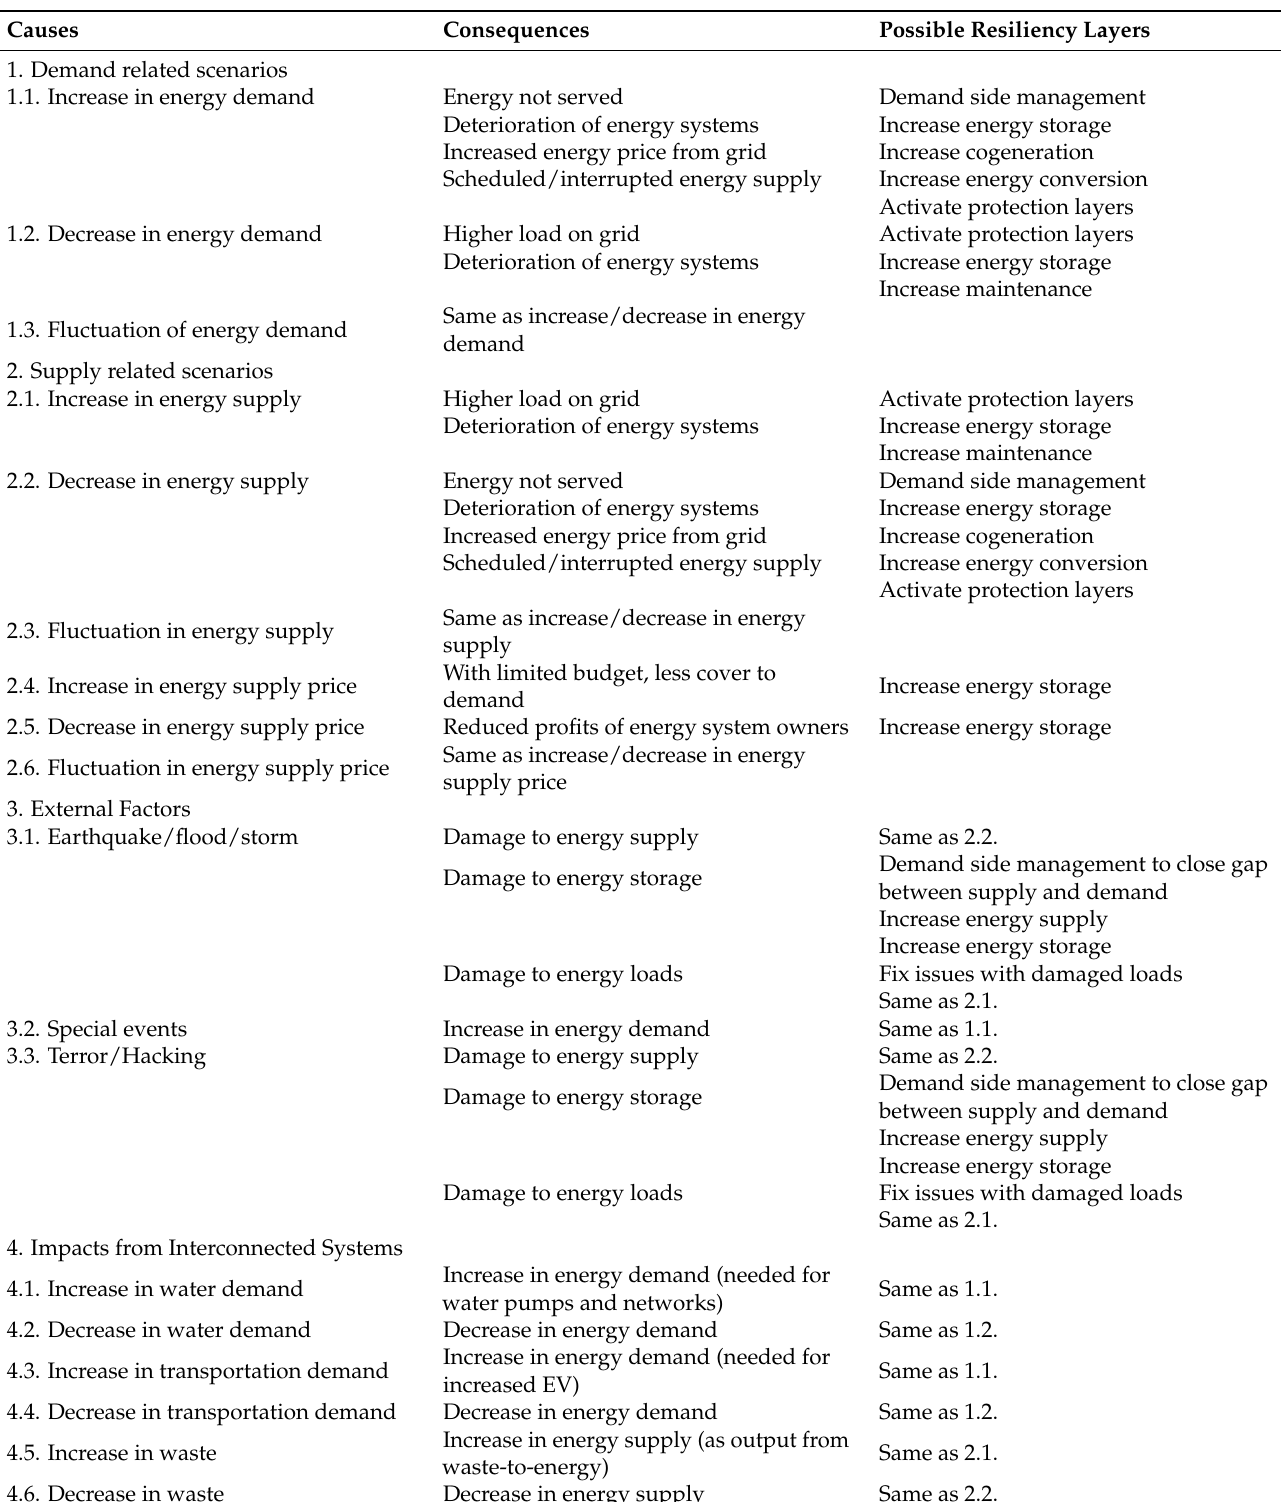
Table 2. Resiliency causation